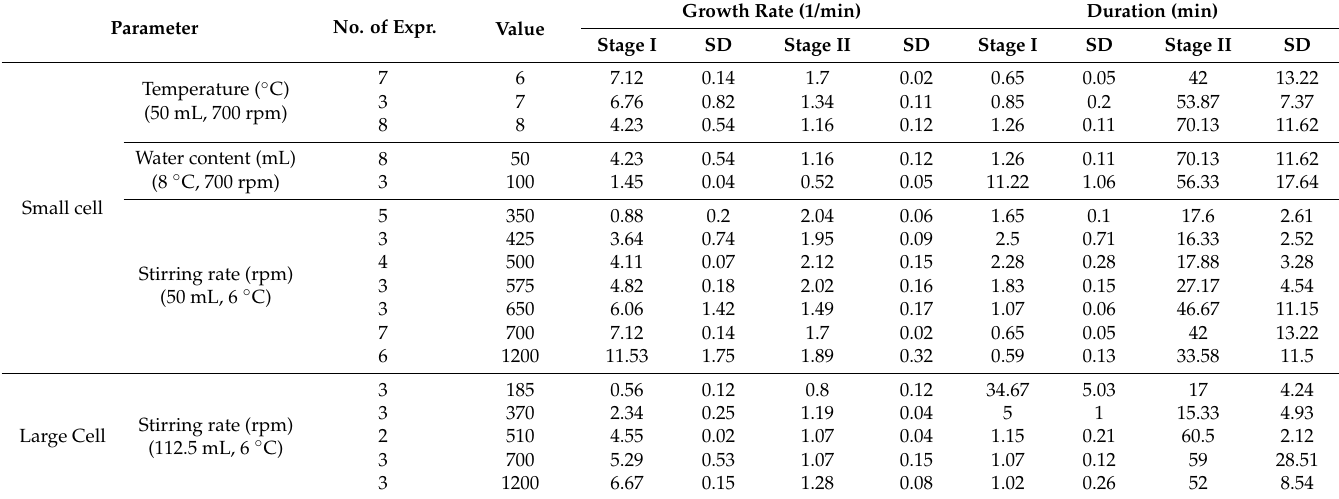
Table 4. Average growth data at different experimental conditions with standard deviations, for stages I and II. SD: Standard Deviations.